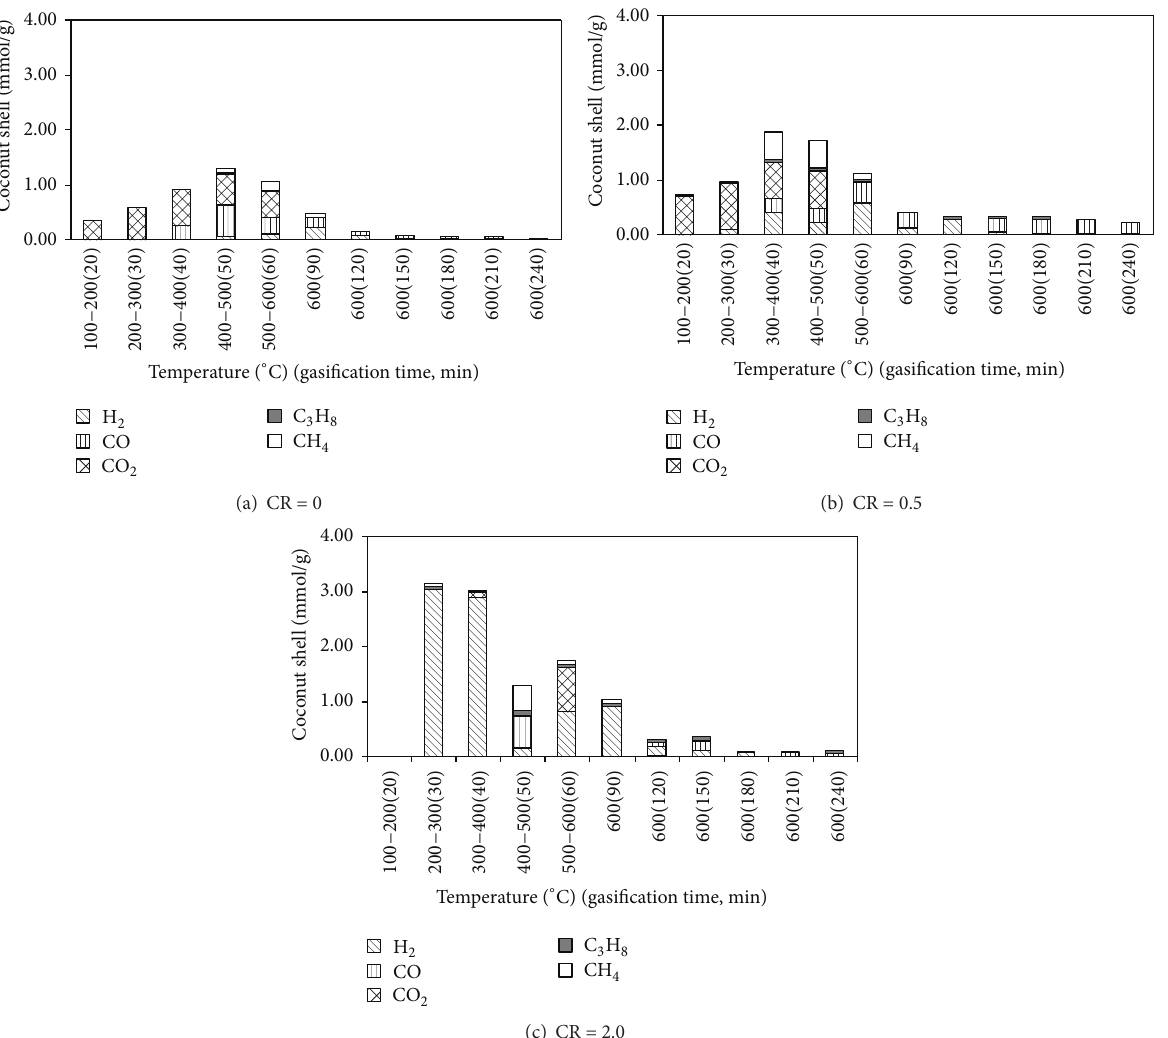
Figure 1: The effect of chemical weight ratio on the composition of gas products generated during the CO 2 gasification at 600 ∘ C for 180min.